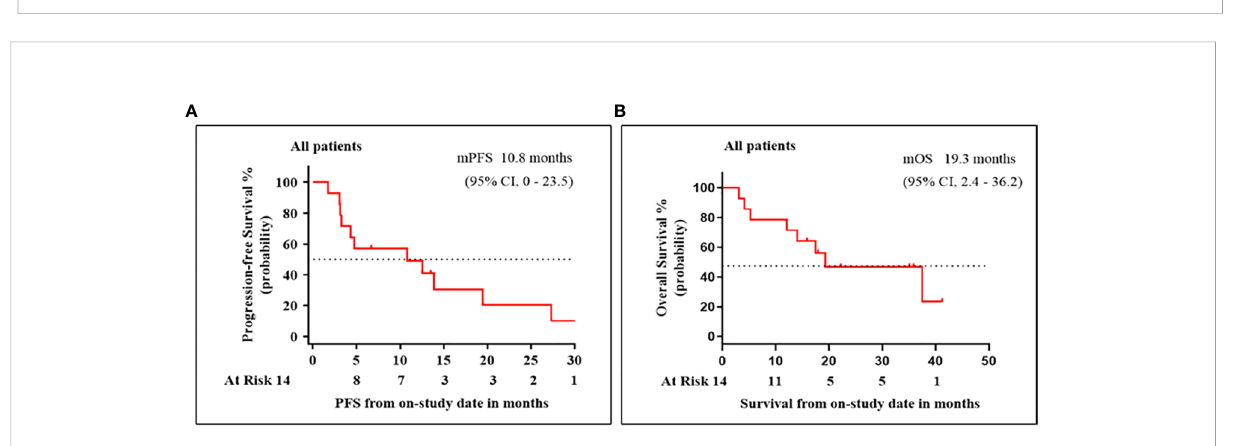
FIGURE 3 Patient survival for treatments with microwave ablation (MWA) in combination with apatinib and camrelizumab. Kaplan – Meier analysis of (A) progression-free survival (PFS) and (B) overall survival